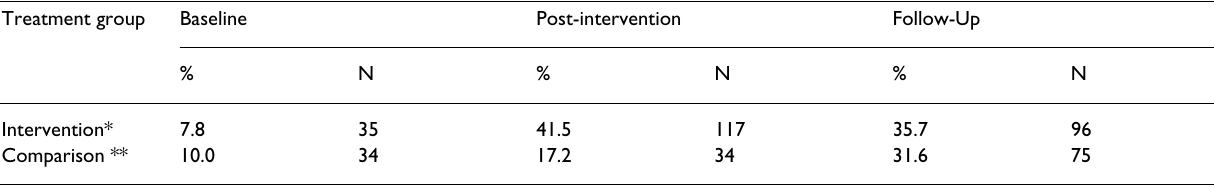
Table 2: Percentage distribution of women who were informed about contraceptive methods Treatment group